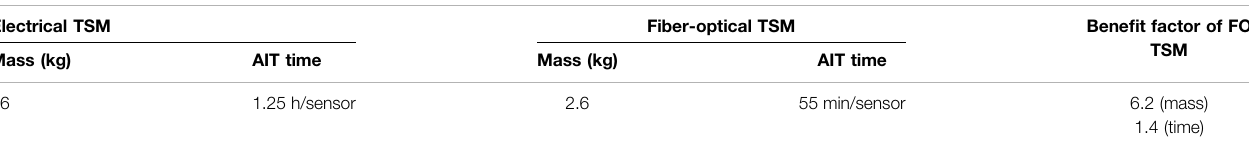
TABLE 2 | Mass and AIT effort of electrical TSM vs. fi ber optic TSM. Electrical